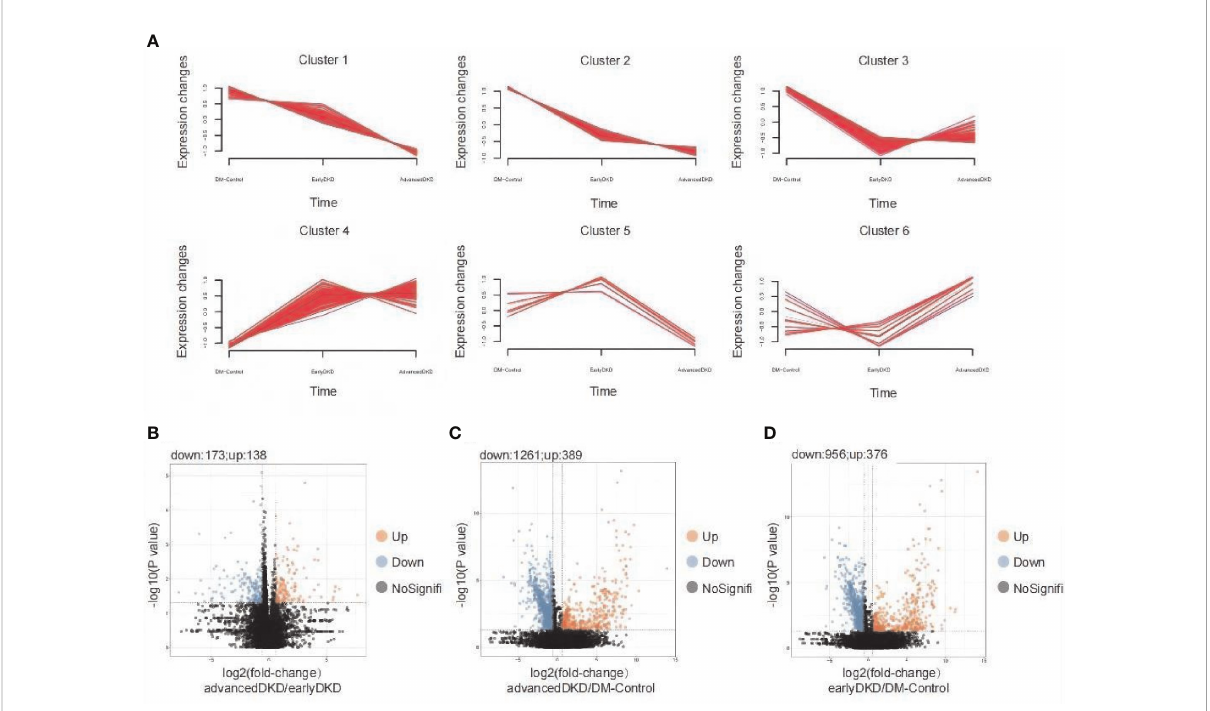
FIGURE 3 Detection and analysis of differentially expressed proteins. (A) Mfuzz analysis of 363 differentially expressed proteins. Volcano plot showing differentially expressed proteins between patients with advanced DKD vs. early DKD (B) , patients with advanced DKD vs. DM controls (C) , and patients with early DKD vs. DM controls (D) using a 1.5-fold – change cutoff and an adjusted p-value threshold of less than 0.05 by ANOVA (p adjusted by Benjamini & Hochberg correction). DM: diabetes mellitus; DKD: diabetic kidney disease; ANOVA: analysis of